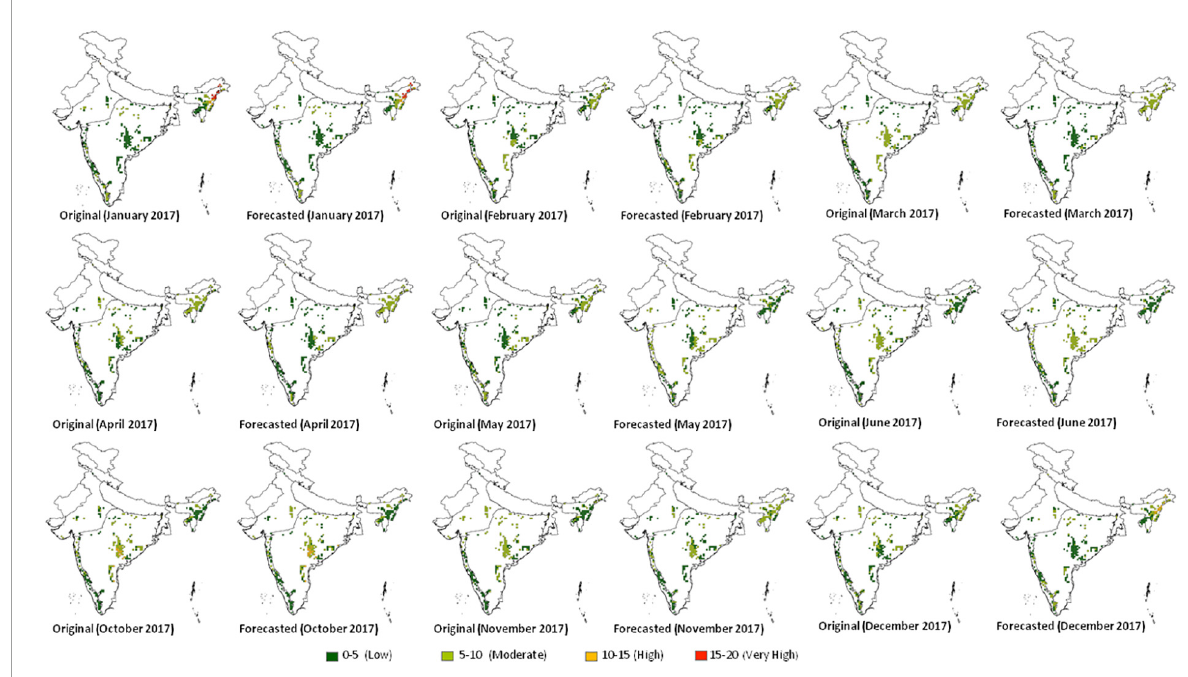
FIGURE11 Original and forecasted forest fire frequency ratio (FFR) for January, February, March, April, May, June, October, November and December 2017 Biogeographic zone-wise (Rodgers and Panwar, 1988; Rodgers et al.,